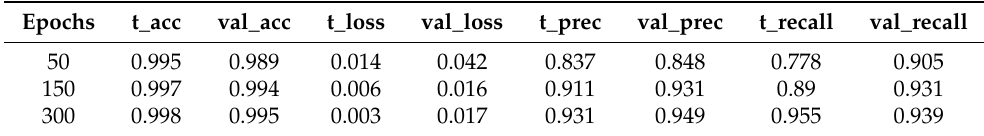
Table 1. Results for the model with binary cross-entropy